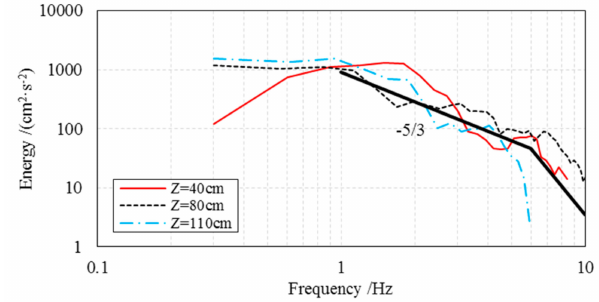
Figure 11. Frequency spectra at di ff erent elevations when s = 0.5 cm and f = 3